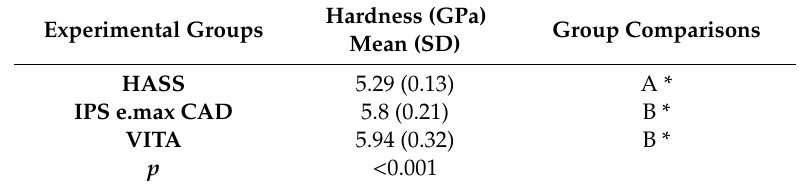
Table 3. Comparison of the surface microhardness according to the type of lithium disilicate block.